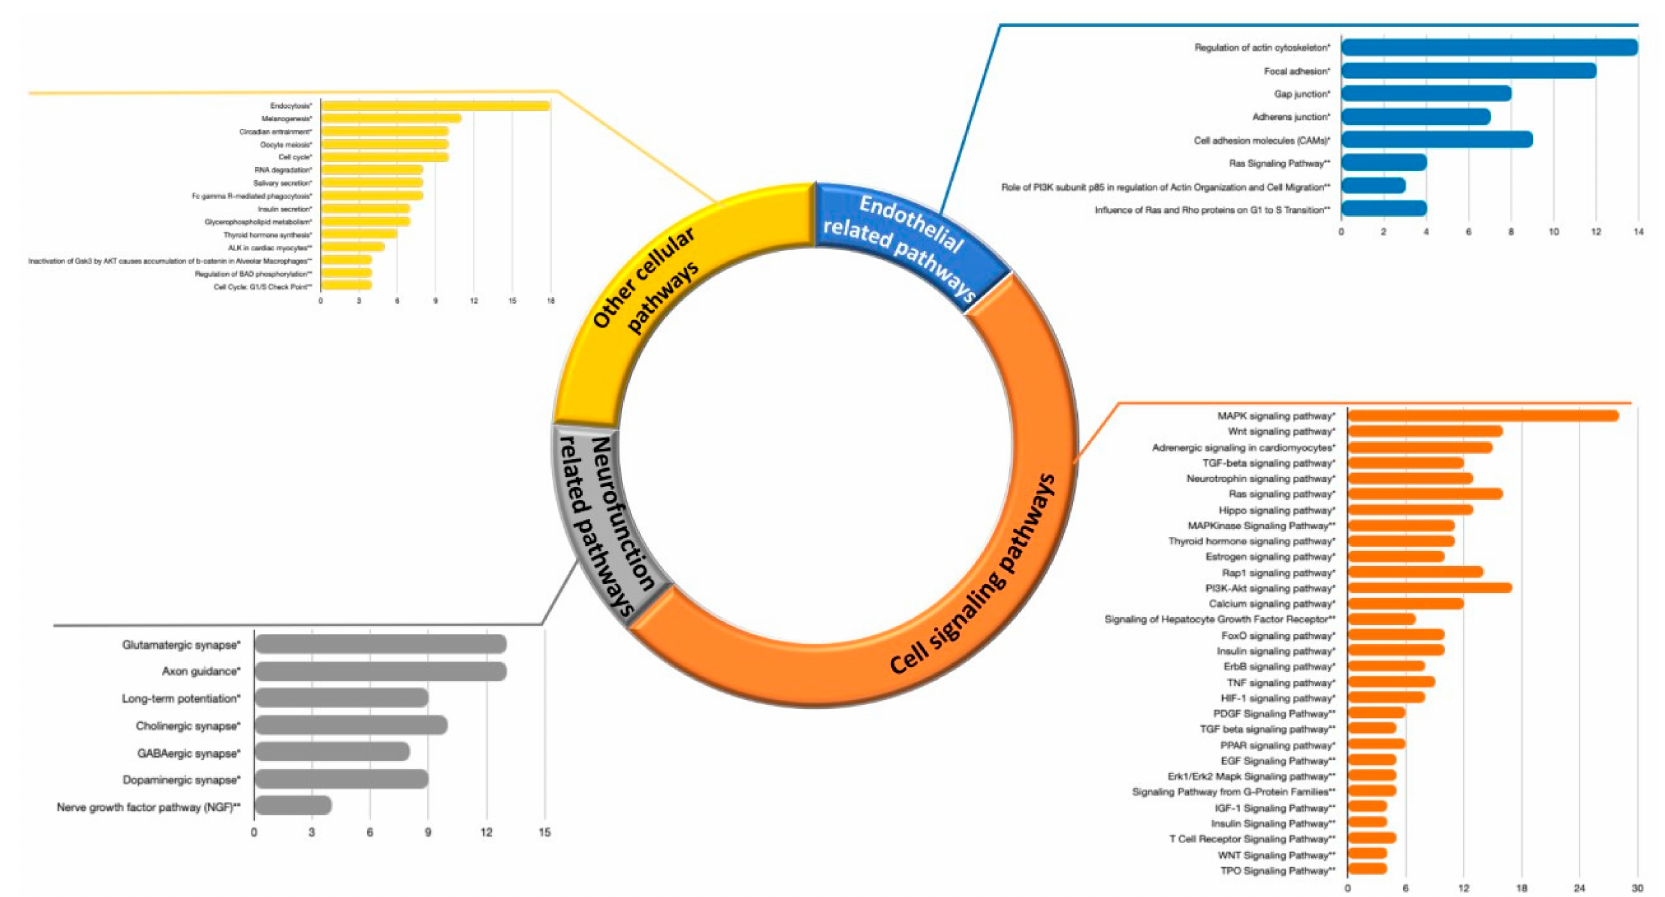
Figure 7. Top 60 KEGG and BioCarta pathways related to cellular processes, significantly associated with predicted miRNA targets ( x -axis represents the number of hits; within each group, pathways are arranged according to their p -values, in ascending order). KEGG pathways are marked with *; BioCarta pathways are marked with